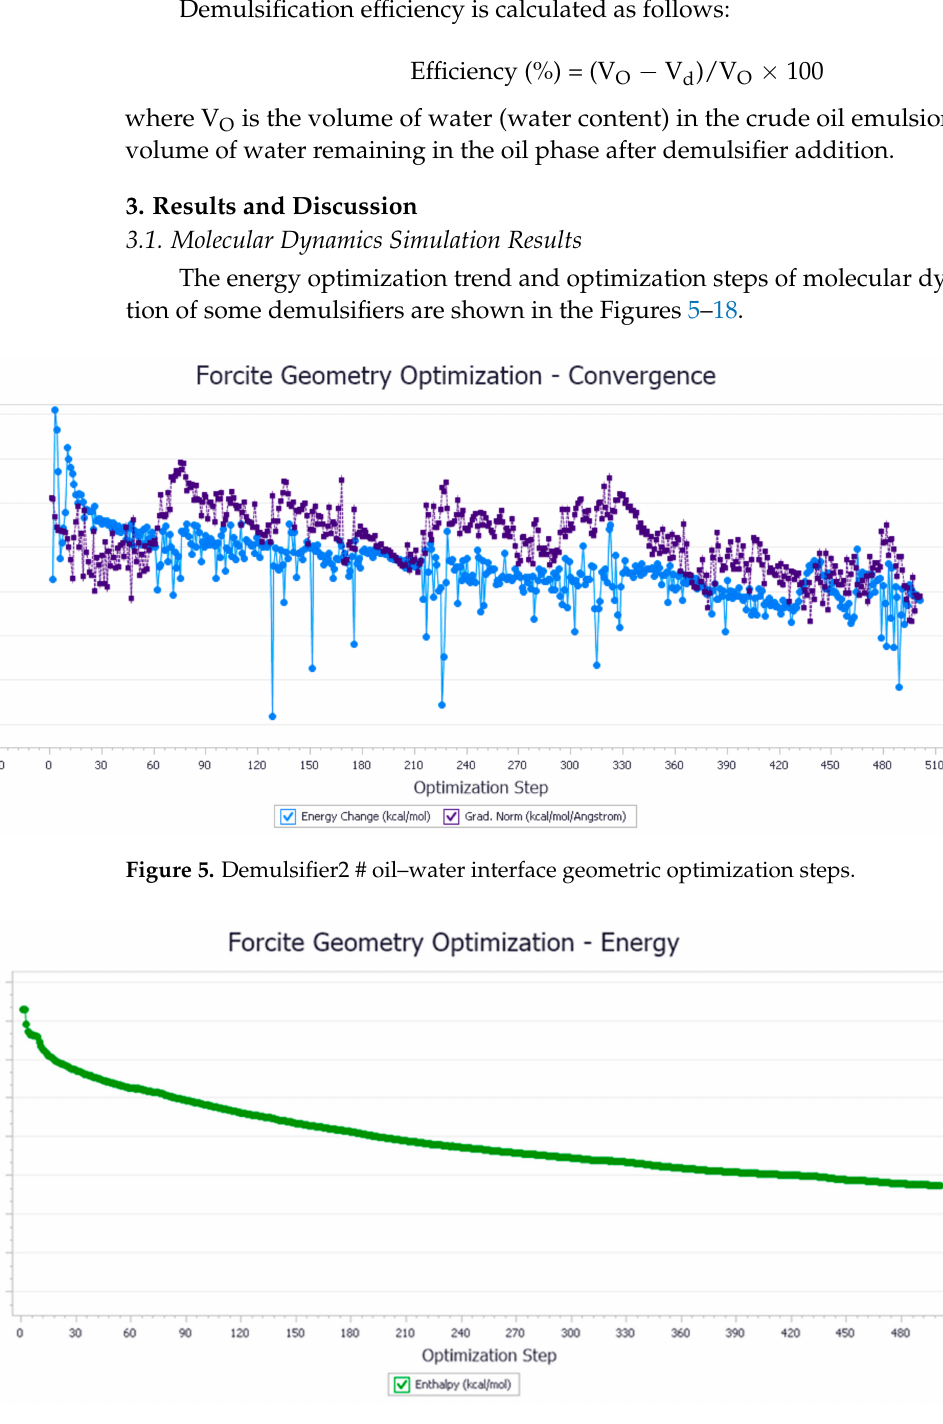
Figure 6. Demulsifier2 # oil–water interface geometry optimization energy